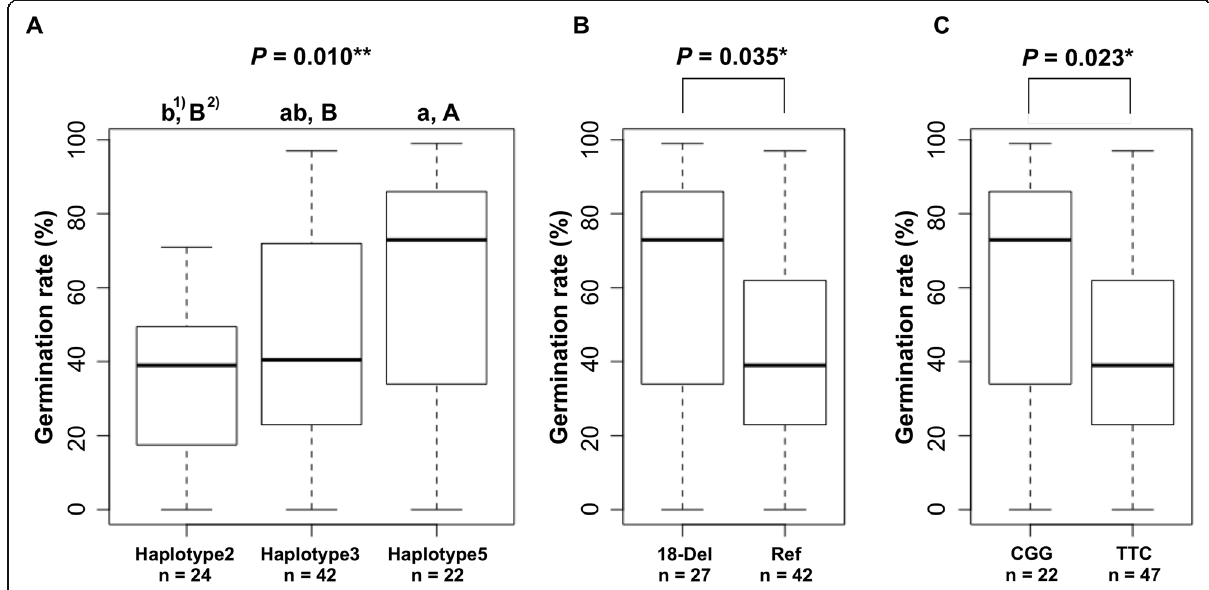
Fig. 5 Comparison of the germination rates ( a ) between haplotypes 2, 3, and 5, and ( b ) between the accessions with the 18-bp deletion and the reference type, and ( c ) between the CGG type and the TTC type. * and ** indicate significant differences of P < 0.05 and 0.01, respectively, as determined from ANOVA and t -tests. 1),2) The same letter is not significantly different among the three haplotypes at P = 0.05 1) and P = 0.10 2) based on Tukey ’ s test,